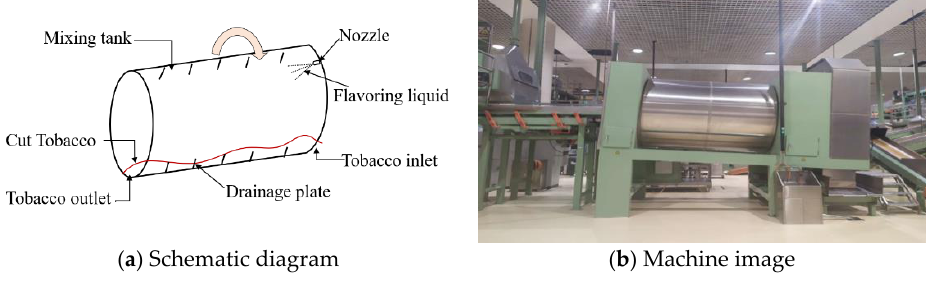
Figure 2. Flavoring